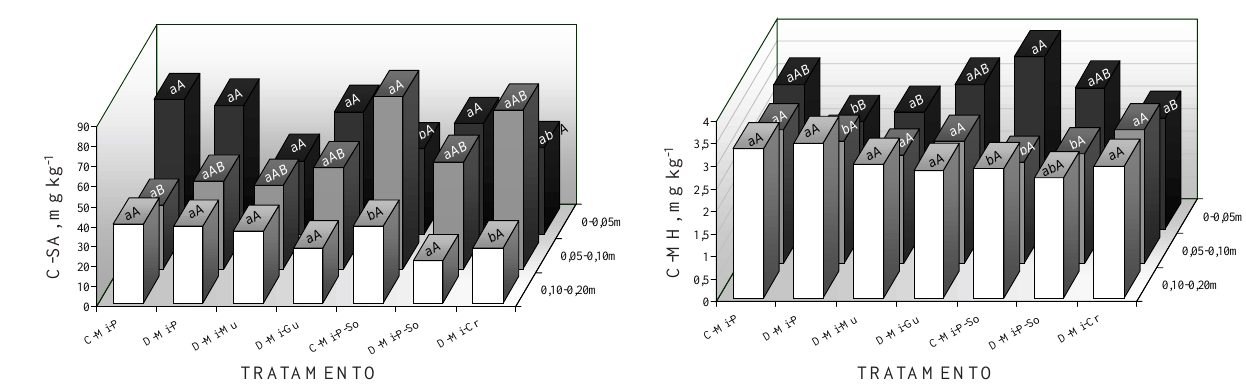
Figura 1. Teores de carbono solúvel em água em um Latossolo Roxo cultivado com milho sob diferentes sistemas de produção por um período de seis anos. C = sistema de semeadura convencional; D = sistema plantio direto; Mi = milho semeado no verão; So = soja semeada no verão; P = pousio no inverno; Mu = semeadura de mucuna preta no inverno; Gu = semeadura de feijão guandu no inverno; Cr = semeadura de crotalária no inverno. Médias seguidas de mesma letra não diferem entre si pelo Teste de Tukey, a 5 %. Letras minúsculas comparam médias dispostas na vertical. Letras maiúsculas comparam médias dispostas na horizontal.